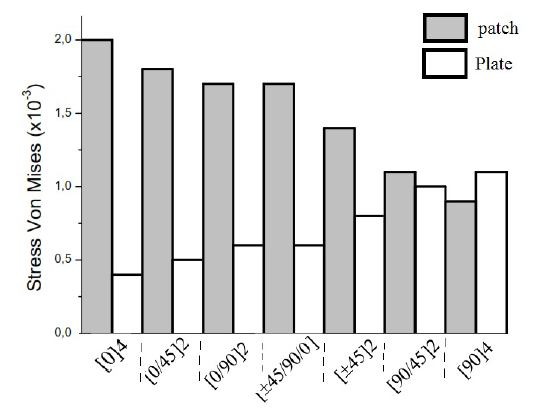
Figure 13. Influence of the patch stacking sequence on the shear stress σ * for a plate [0/45] 2s.